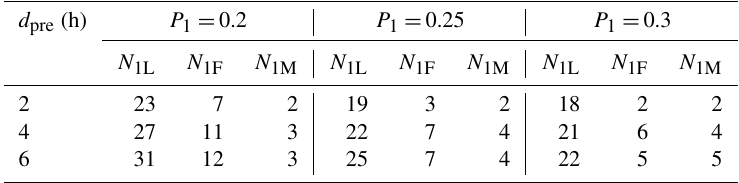
Table 2. Stochastic approach to early warning: numbers of launched ( N 1L ) , false ( N 1F ) and missing ( N 1M ) alerts at the slope of Pessinetto for three different lead times t pre and three different choices of the probability of alert activation P 1 . For each lead time, the system carried out 964 predictions between 11 September 1991 and 15 June 2004 (validation period).